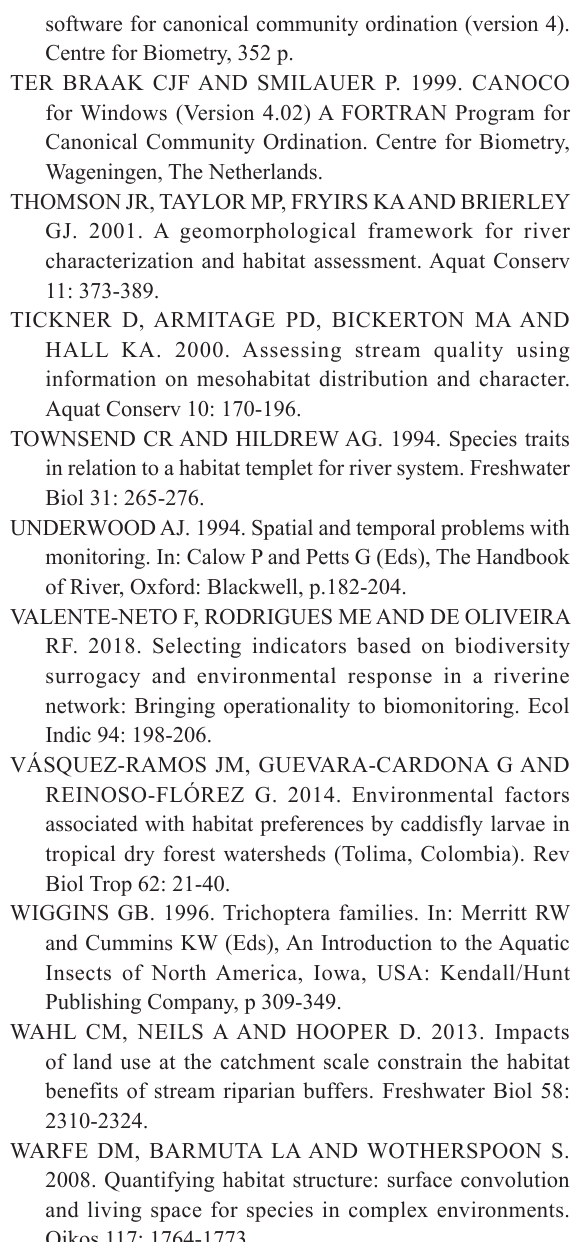
Table SI - location of study sites in streams of Carcarañá River basin (1: Río de los Sauces, 2: el Talita, 3: las Cañitas, 4: Piedras Blancas) and physico-chemical characterization of water during high and low water periods. Mean values are shown with standard deviations. Dissolved oxygen was measured only once at each site and hydrological period. TDS: Total dissolved solids. Coordinates delimit stream segment that included sampled